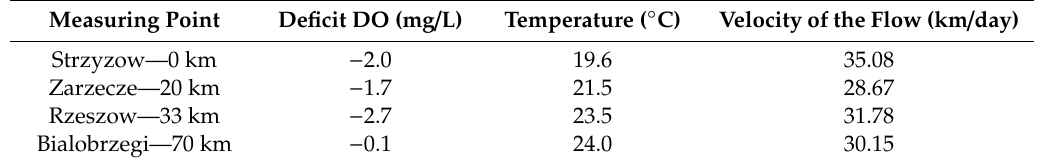
Table 5. Real results for Wislok River at section Strzyzow–Bialobrzegi [24]. Measuring